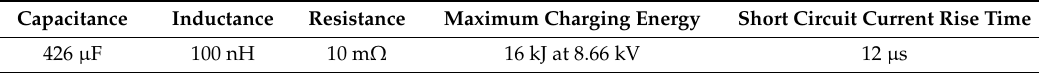
Table 1. Capacitor bank